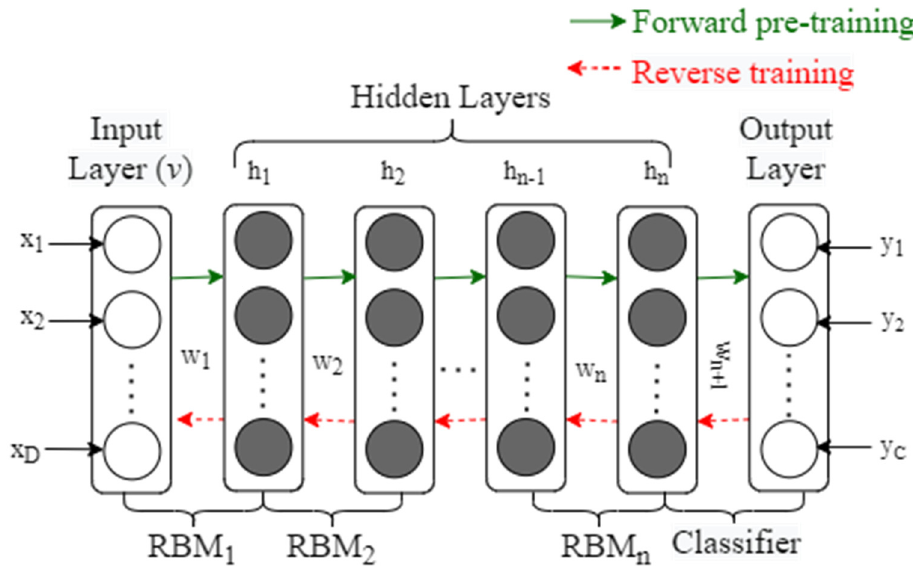
Figure 2. Layout of deep belief network (DBN).